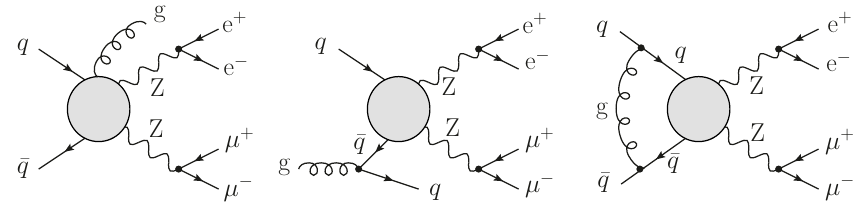
Figure 2 . Sample tree-level and one-loop contributions to NLO QCD real and virtual corrections to resonant ZZ production. The shaded circle denotes arbitrary tree-level